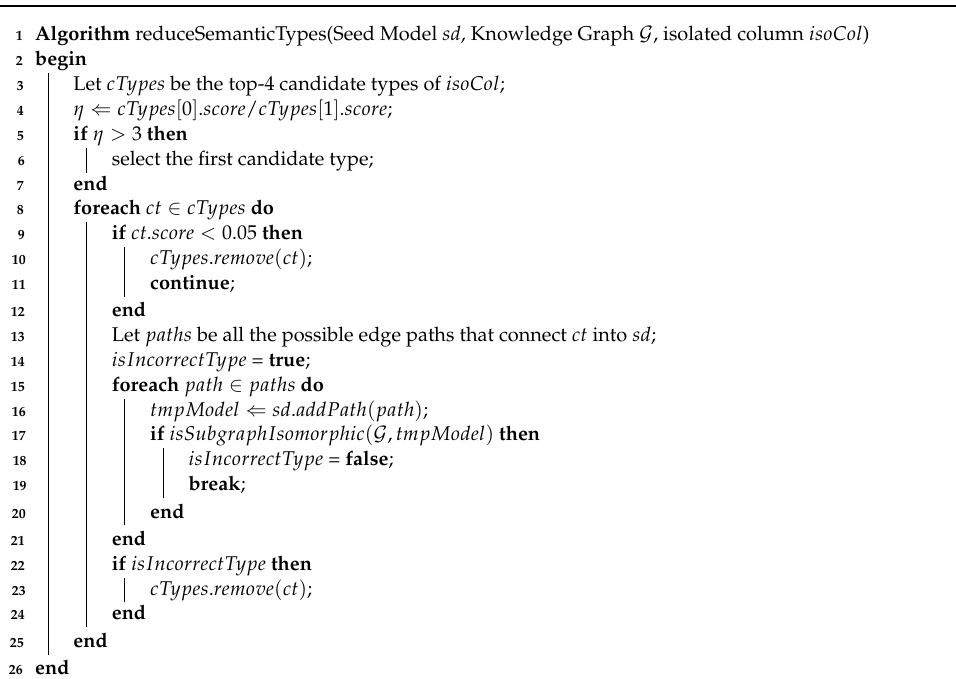
Algorithm 2: Algorithm of reducing candidate semantic types for an isolated column.